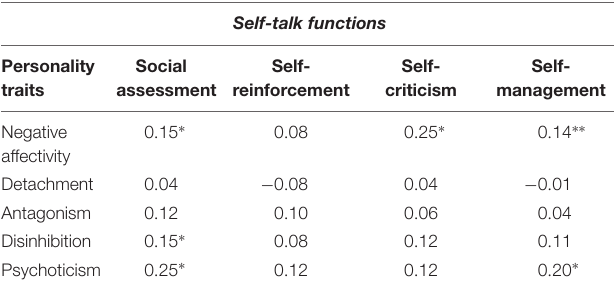
TABLE 2 | Pearson’s correlation for pathological personality traits (PID) and self-talk functions (STS). Self-talk functions